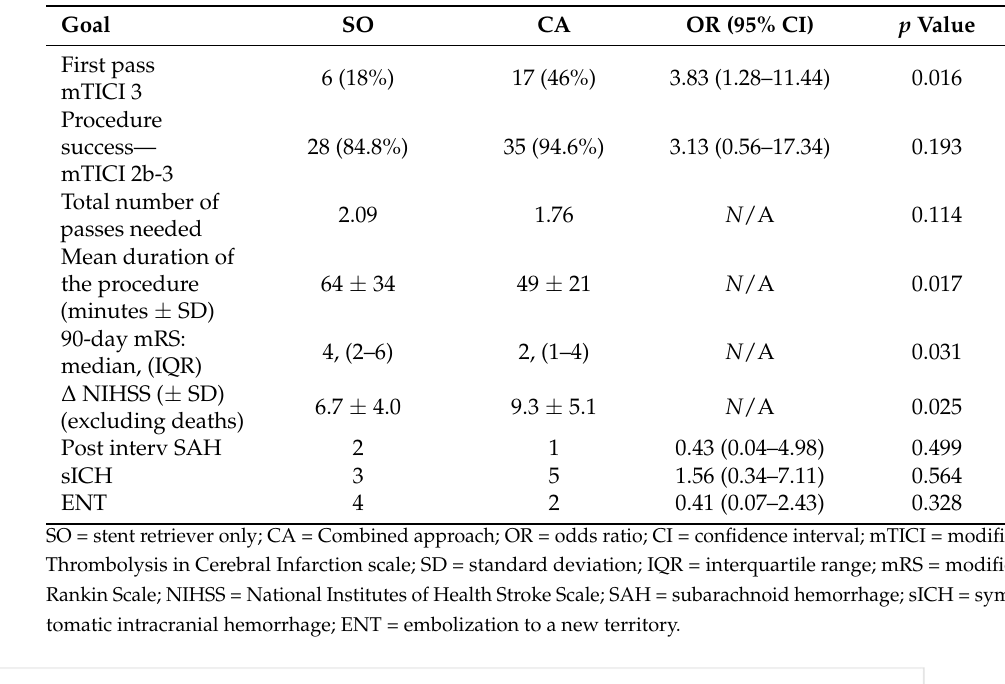
Table 2. Results of the study endpoints analysis.